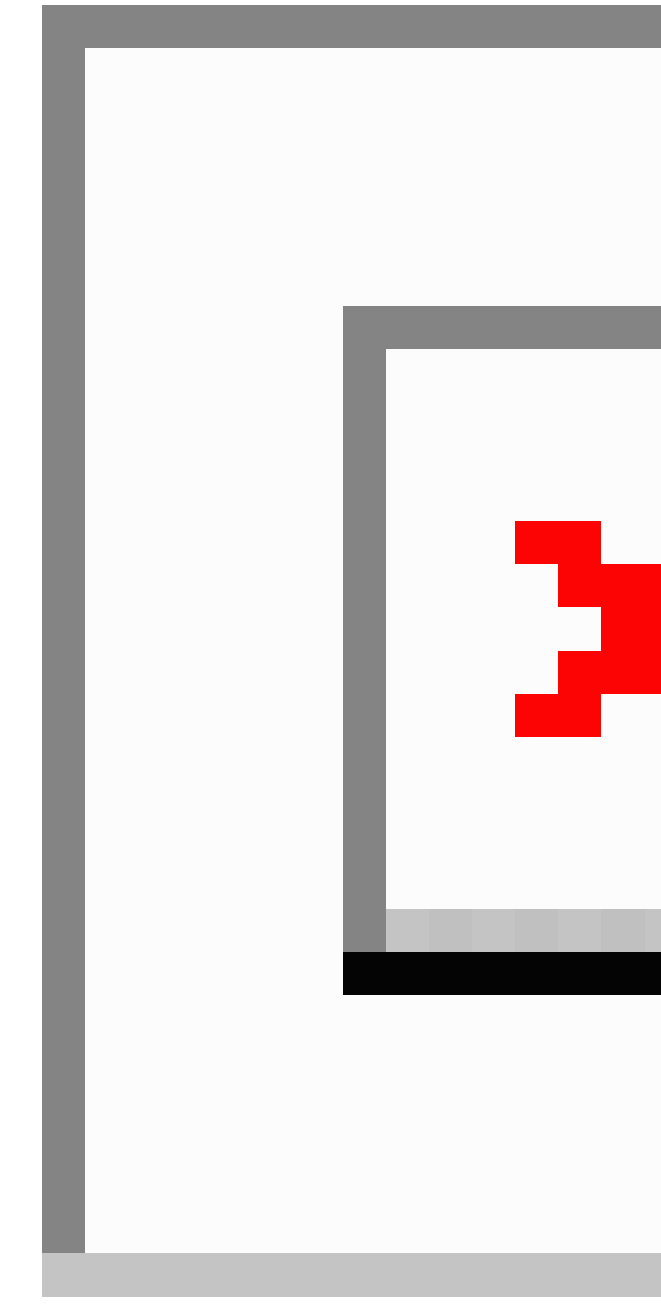
Figure 1. Overall architecture for remote patient monitoring.